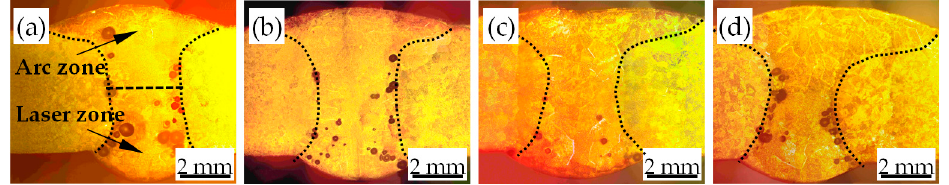
Figure 8. Cross-sectional morphology of laser–TIG hybrid welded joints with different currents: ( a )